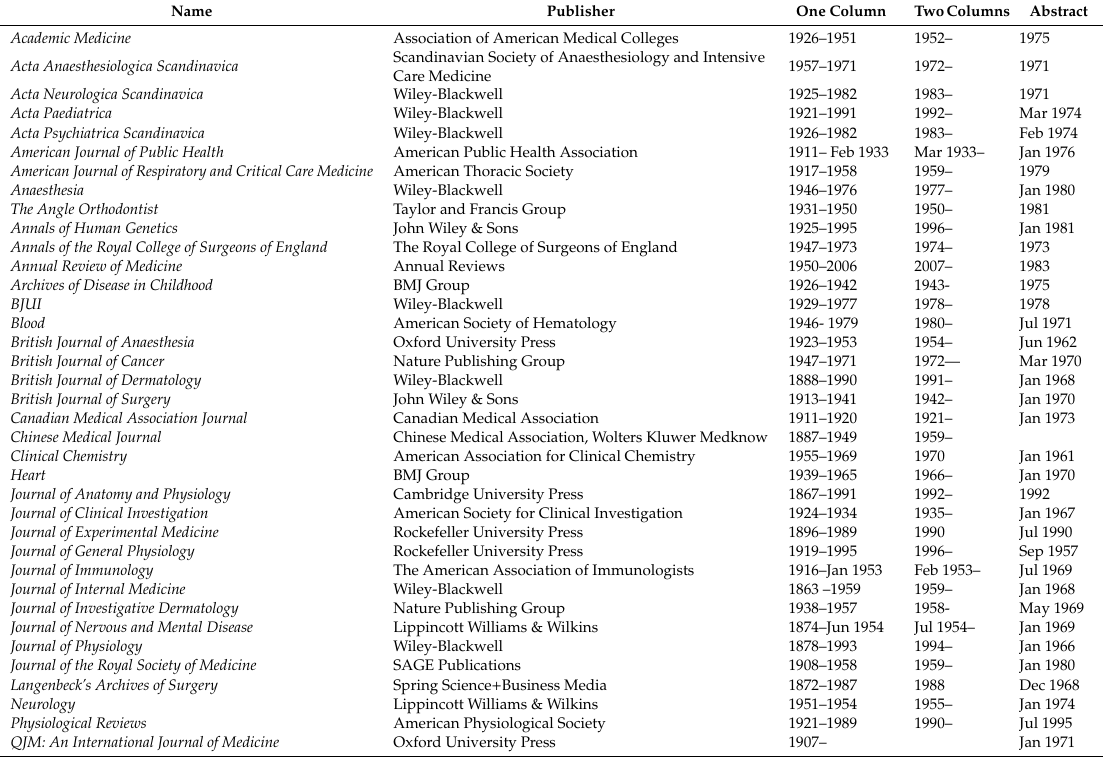
Table 1. This is the list of the included journals, their publishers, the date the journal opted for a single-column or double-column layout and the appearance of